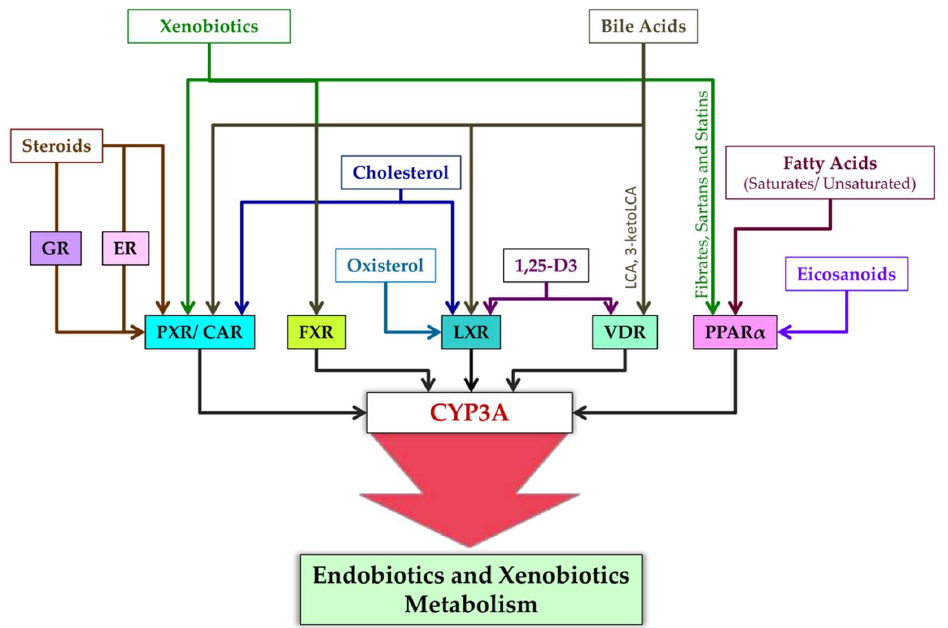
Figure 4. Ligands of nuclear receptors modulating CYP3A